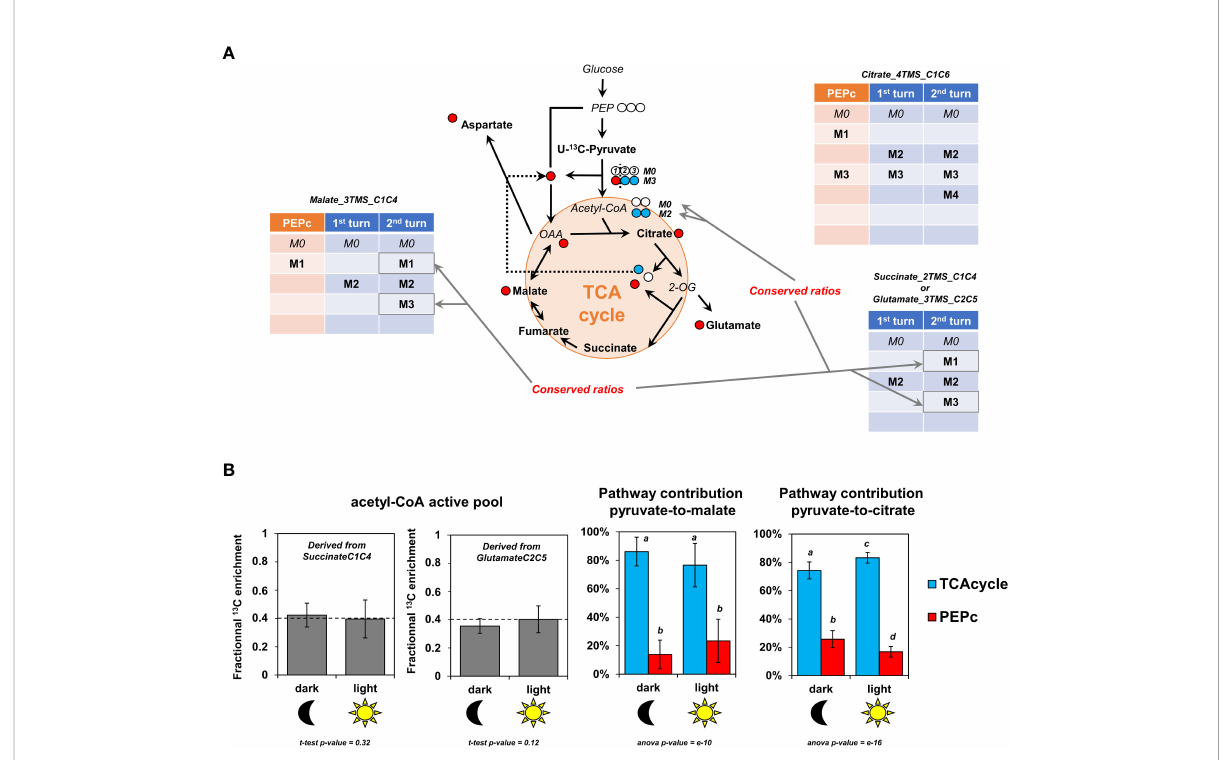
FIGURE 6 Fractional contribution of TCA cycle and PEPc-dependent reassimilation of mitochondrial CO 2 for pyruvate to malate and pyruvate to citrate in light and dark conditions. (A) , Pathway-speci fi c mass isotopologues considered for the calculations. (B) , Fractional contribution of PEPc and TCA cycle to malate and citrate based on pathway-speci fi c mass isotopologues/isotopomers. For these calculations, only the timepoint T4 and T6 hours were used and pooled (metabolic steady-state and isotopic steady-state for isotopologue ratios). The results are presented as the mean ± SD of four independent biological replicates. Statistical comparison of acetyl-CoA enrichment for light and dark conditions was performed with a Student-test, while fractional contributions were compared with an ANOVA followed by a post-hoc Tukey-HSD test (different letters indicate groups that were separated with a p-value <